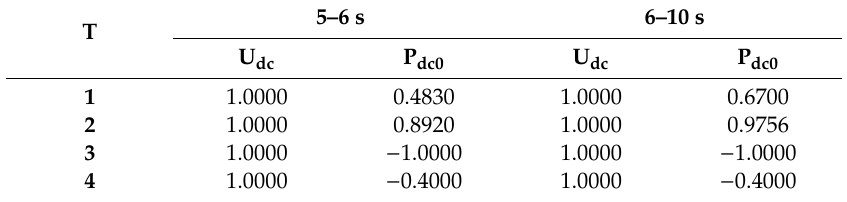
Table A3. The initial nodal voltage and active power reference in the multi-point voltage control (p.u.).